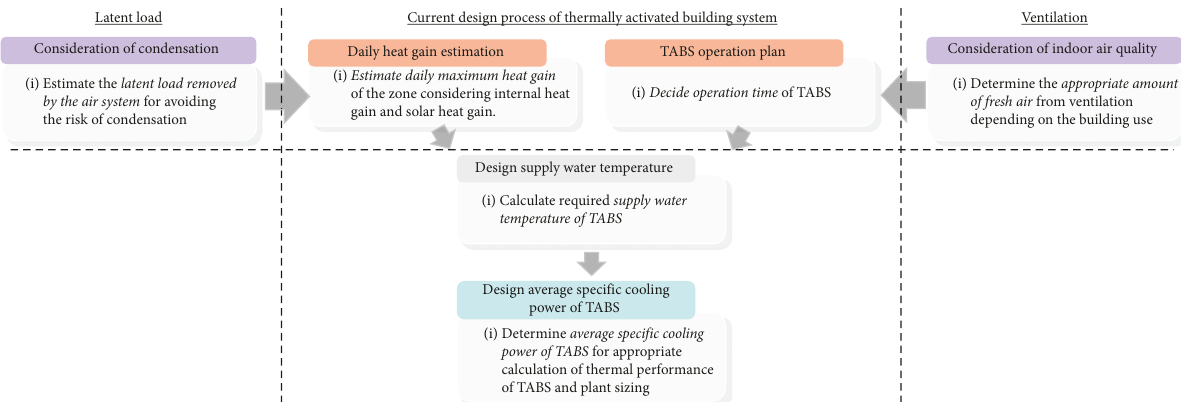
Figure 1: Current design method in ISO 11855 part 4 and additional